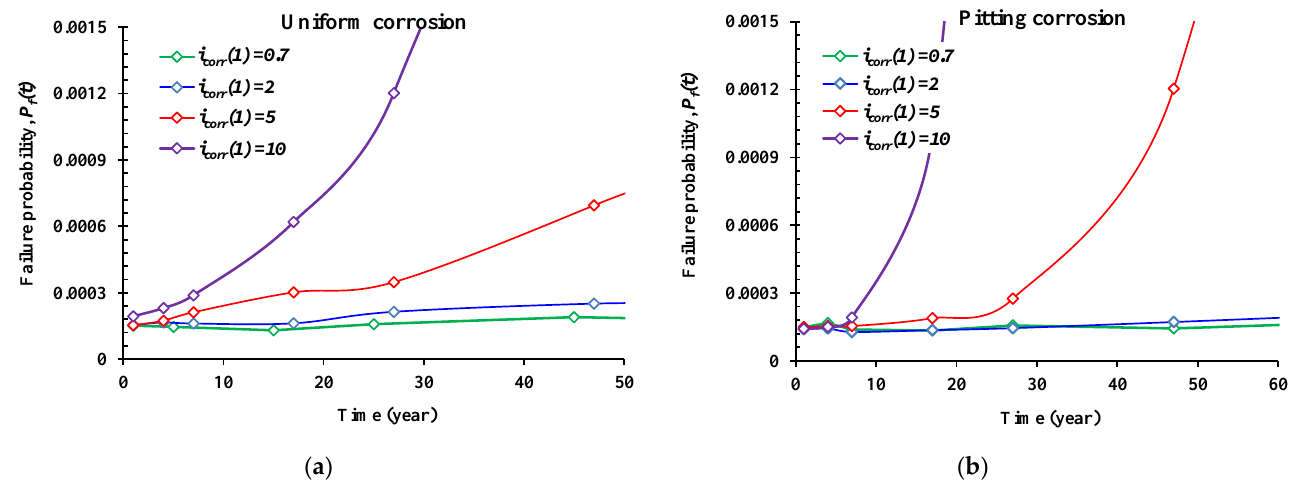
Figure 6. Influence of the corrosion rate at the beginning of propagation ( icorr (1)) on the reliability results. ( a ) Uniform corrosion form, ( b ) pitting corrosion form.